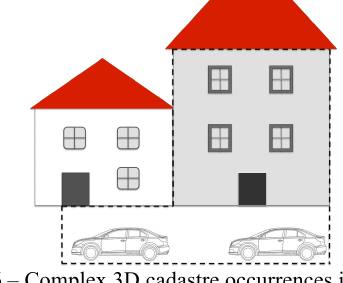
Figure 6 – Complex 3D cadastre occurrences in Coimbra (Portugal): underground garage underneath a next-door building.